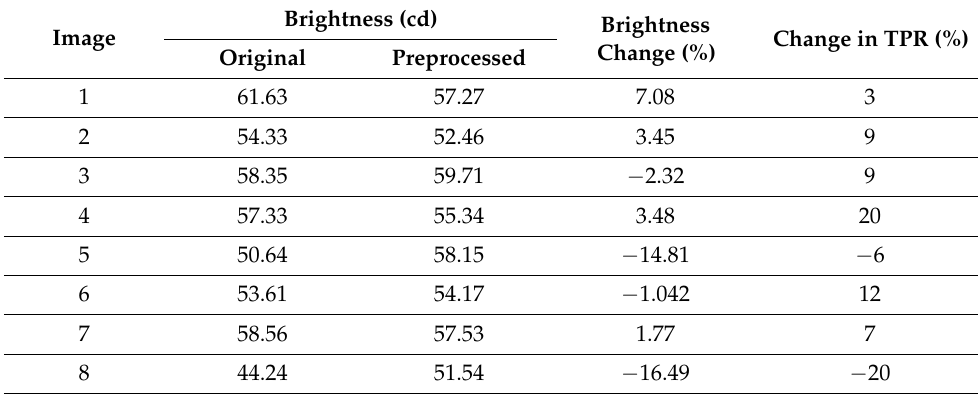
Table 5. Comparison of brightness values of original and preprocessed